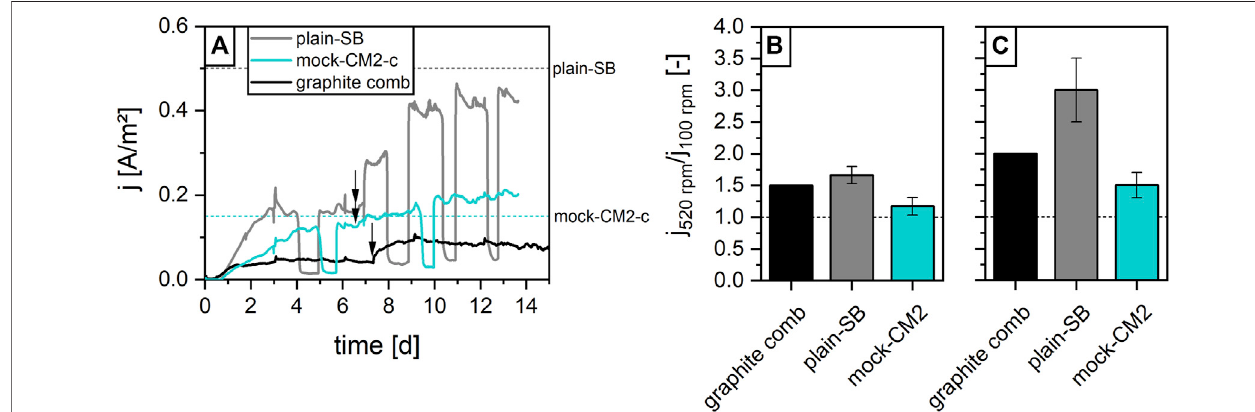
FIGURE6| Currentproductionby S.oneidensis insinglechamberBESequippedwithmocklenofabricsandtwocontrolelectrodes(graphitecombandplain-SB). (A) Overview withrepresentative data,plain-SB: n =2,graphitecomb: n =1,mock-CM2-c: n =2;mock-CM2-cisfurthermorerepresentative formock-CM2 samplesin general. Sharp current drops and increases result from electron donor depletion and new addition. Arrows indicate switch from 100 to 520 rpm stirring speed. (B,C) Relationship between current generation at high and low stirring speed (520/100 rpm), (B) 60 min before/after switch and (C) overall j max achieved with given stirringspeeds.Avalueof1.0(dottedreferenceline)meansthattheswitchdidnotaffectthecurrentgenerationatall.Shownareresultsofplain-SB: n =2,graphitecomb: n = 1, and combined results of all 4 mock-CM2 ( n = 8 in total, n = 2 per sample a/b/c/d). Error bars show deviation from mean. All current densities are reported with respected to two sides of the planar electrode (2x projected surface area). Technical details on electrode materials are given in Table 1 and Supplementary Table S6